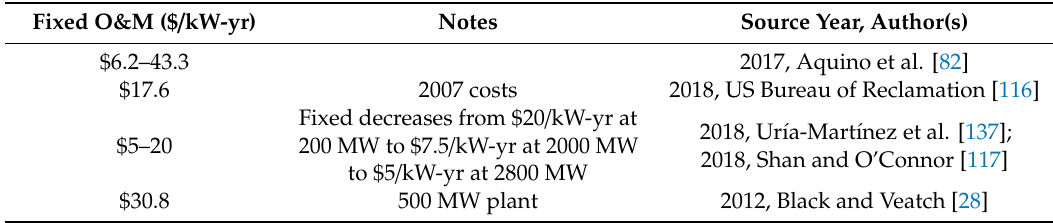
Table 24. Fixed O&M costs—PSH technology.